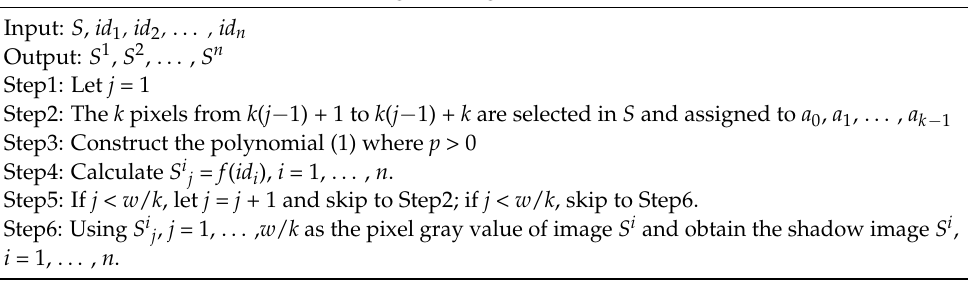
Algorithm 1 Thien and Lin’s secret image sharing